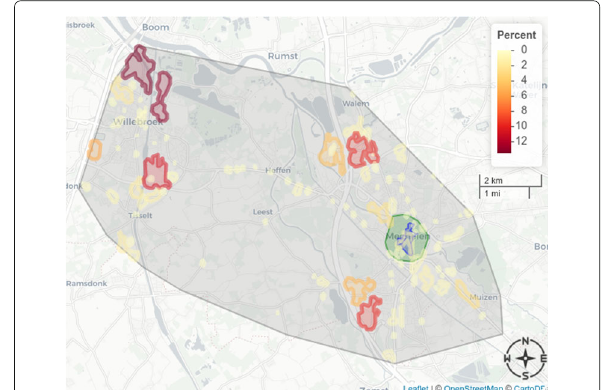
study to date has reported on similar analysis. (iv.) We validation results of ANPR analysis using GPS data from on-board units of